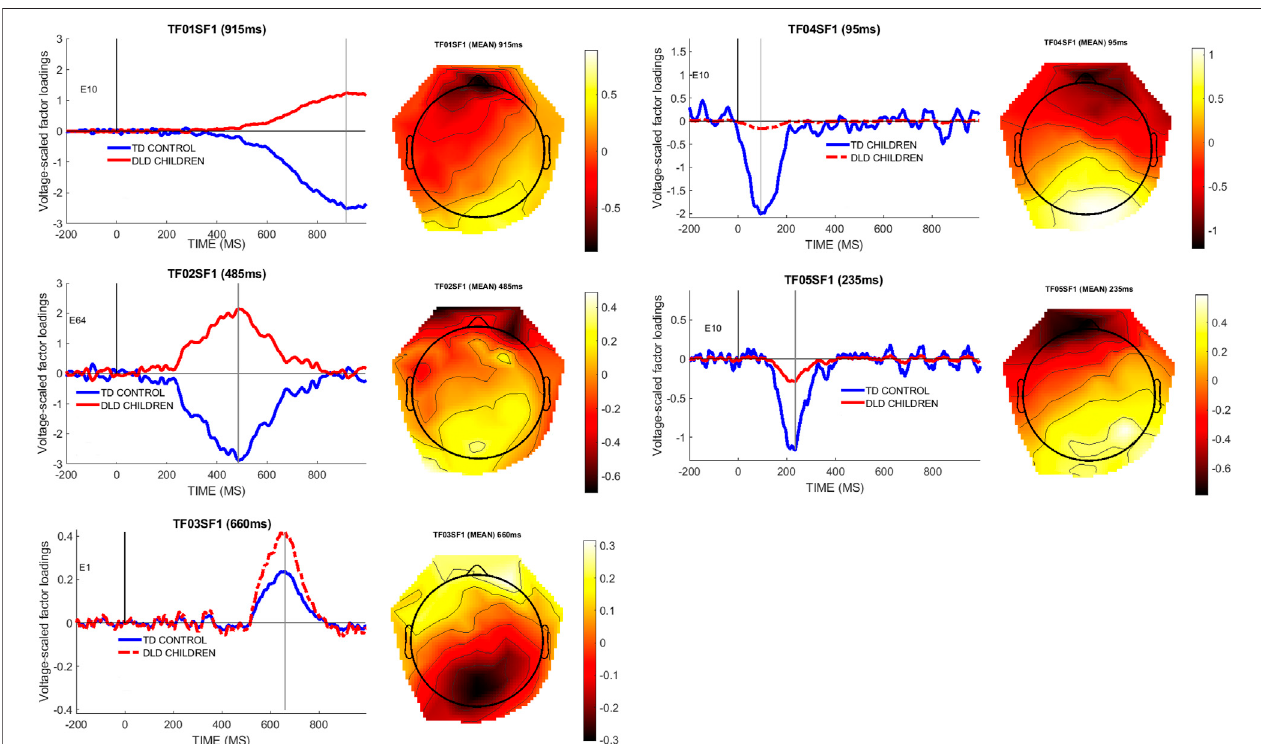
FIGURE 6 | Temporal factors (peak latency indicated) and their spatial distribution; left panels show the microvolt-scaled factor loading waveforms by group. The right panels show the spatial distribution of the effects by using the mean (main effect) spatial component. Note that groups only differ from each other in the